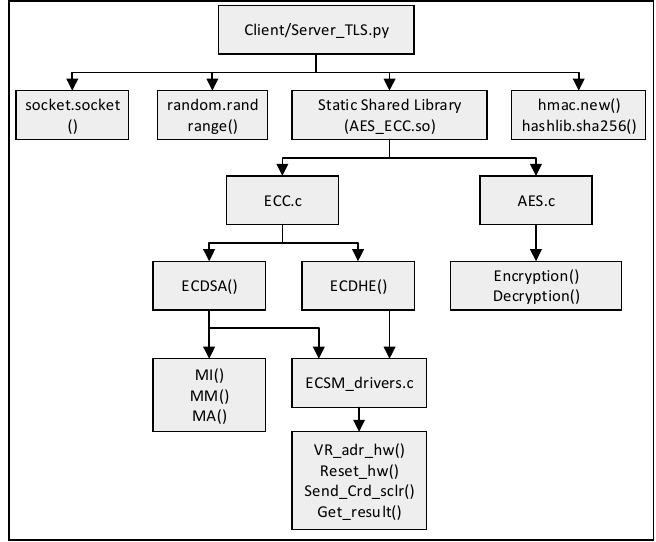
Figure 7. TLS software functions.